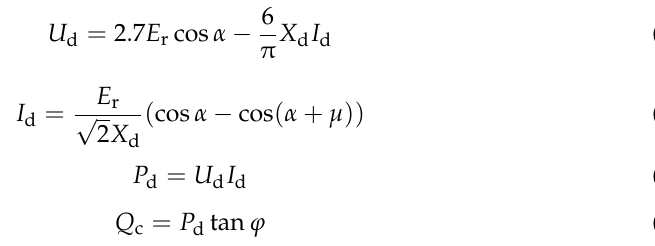
Figure 4. Schematic diagram of 12 − pulse LCC converter.